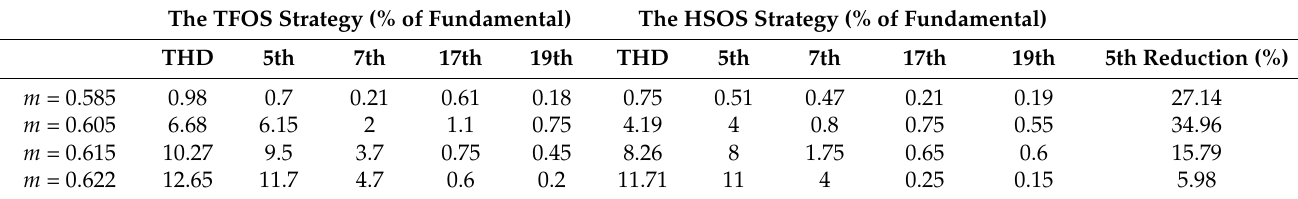
Table 5. Experiment voltage values of two strategies. The harmonic content of line voltage and current of both strategies are listed in Ta-